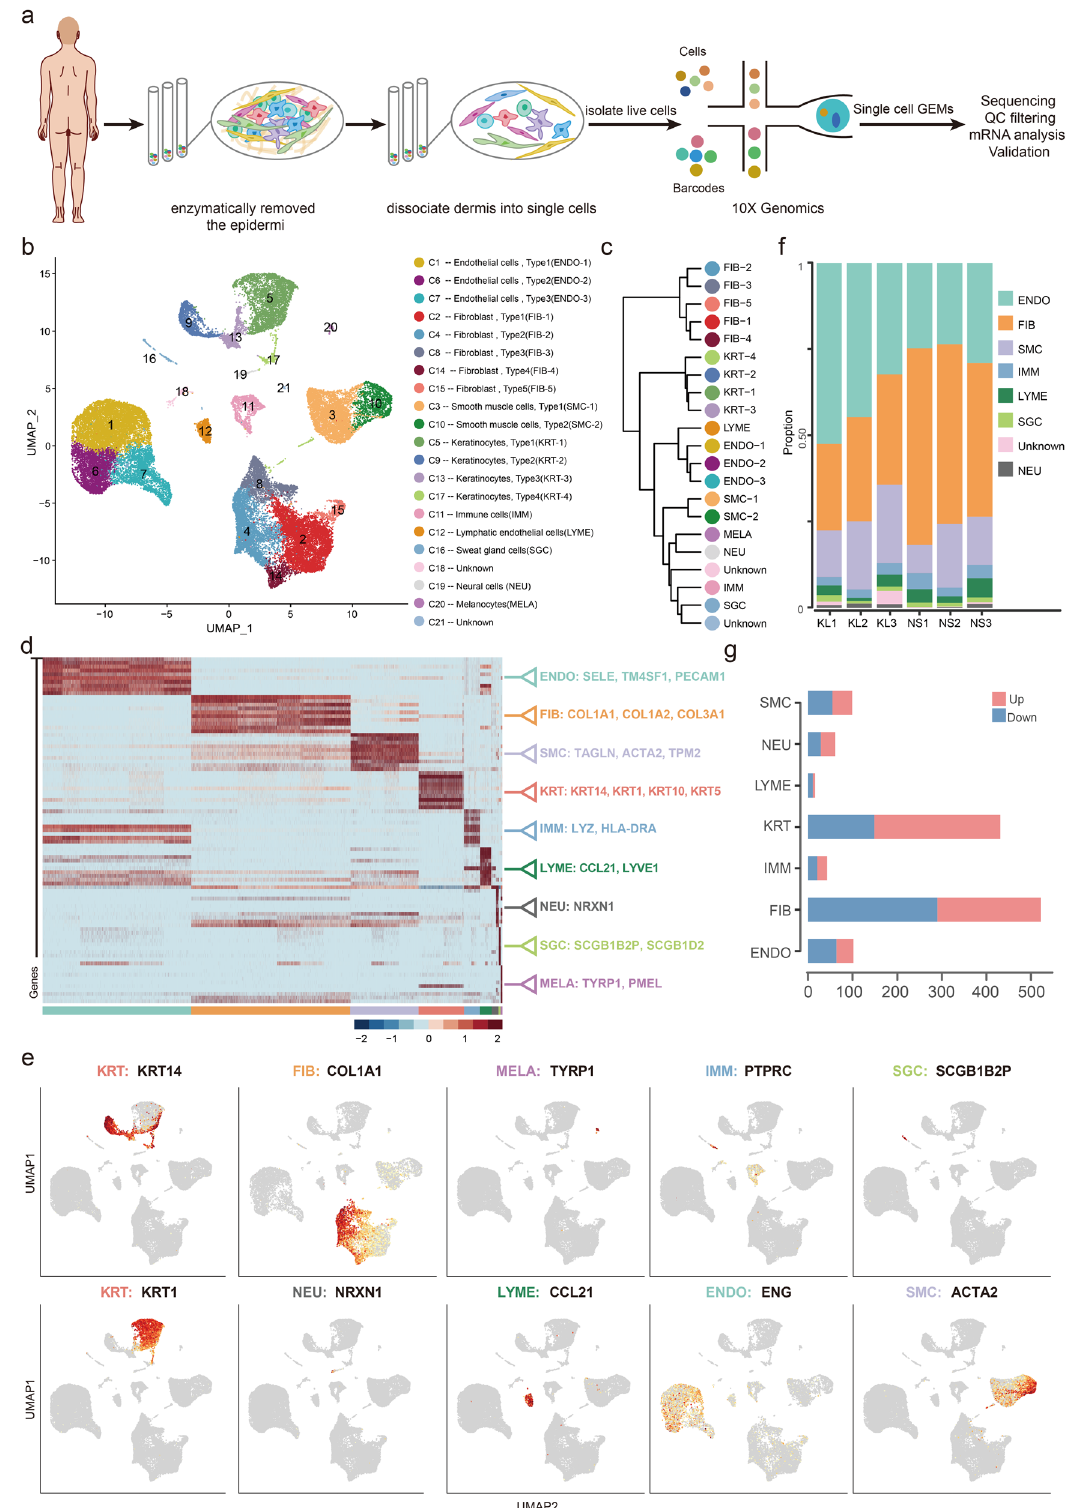
subpopulations between keloid and normal scar. The results showed that the proportions of secretory-papillary, secretory- reticular, and pro-in fl ammatory subpopulations were decreased, while the mesenchymal subpopulation was increased in keloid compared to normal scar (Fig. 2f). The increased mesenchymal subpopulation in keloid suggested that this population may be very important for keloid